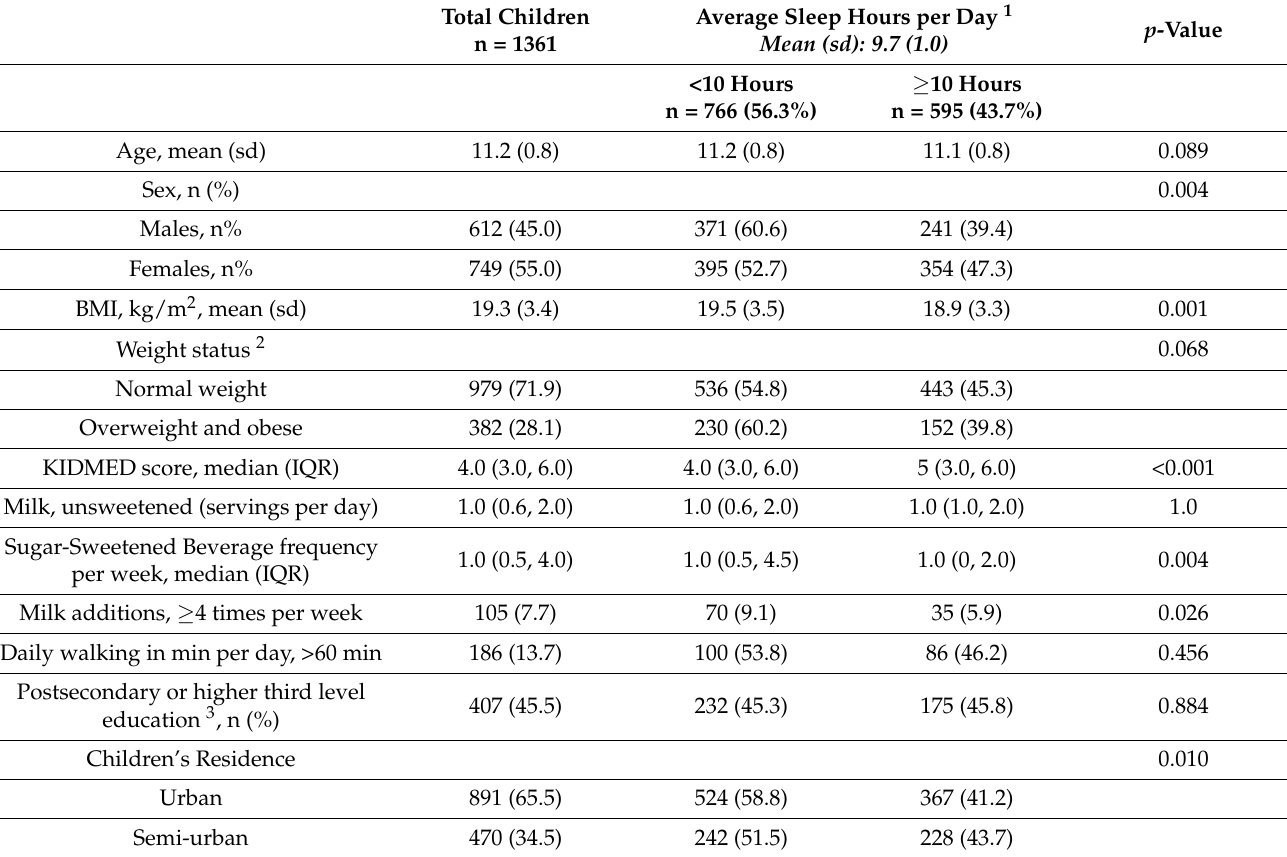
Table 1. Baseline characteristics of children enrolled in the study in total and stratified by recom- mended mean hours of